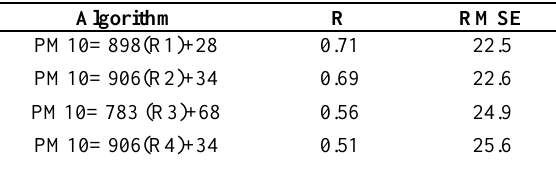
band (red). Table 2. The relationship between atmospheric reflectance of Landsat-8's first to fourth bands with PM10